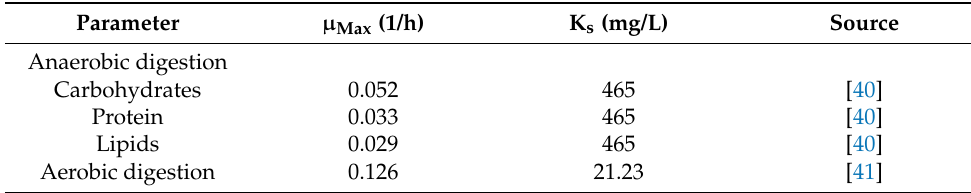
Table 2. Kinetics’ parameters for anaerobic and aerobic